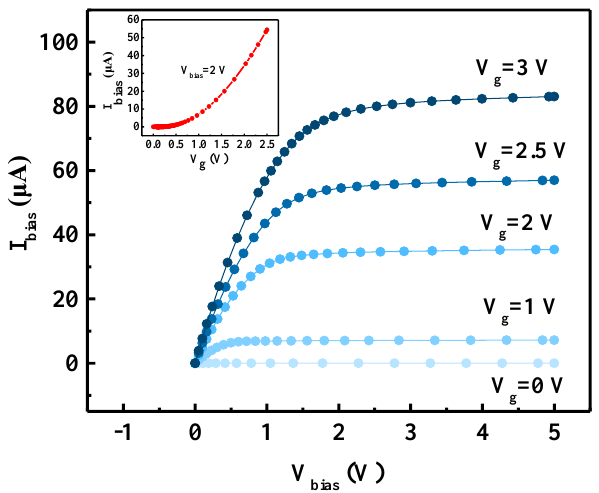
Figure 2. Dependencies of bias current I bias on the bias voltage V bias at various gate voltages V g of the FD-SOI Hall sensor. The inset is the transfer characteristic curve, which shows the variation of I bias with V g .